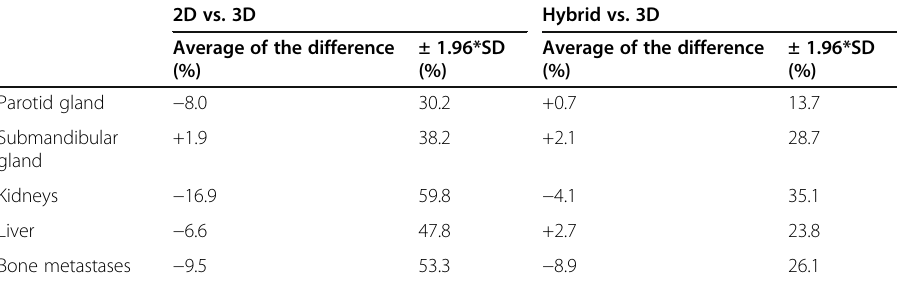
Table 4 Results of Bland-Altman analysis in terms of the percent average of the difference and the respective ±1.96*SD for the normal tissues and the bone metastases 2D vs. 3D Hybrid vs. 3D Average of the difference ± 1.96*SD Average of the difference ± 1.96*SD (%) (%) (%) (%) Parotid gland − 8.0 30.2 +0.7 13.7 Submandibular +1.9 38.2 +2.1 28.7 gland Kidneys − 16.9 59.8 − 4.1 35.1 Liver − 6.6 47.8 +2.7 23.8 Bone metastases − 9.5 53.3 − 8.9